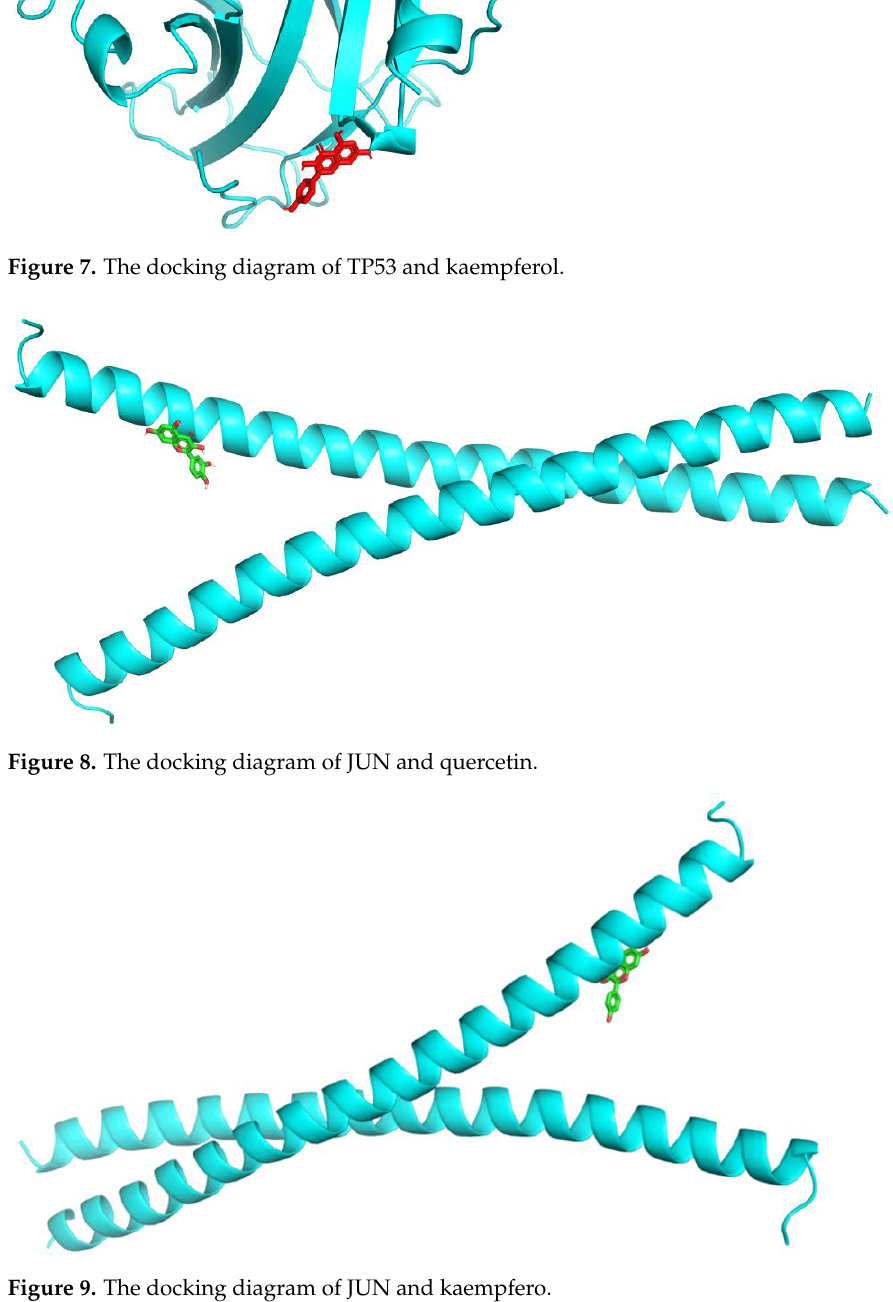
Figure 9. The docking diagram of JUN and